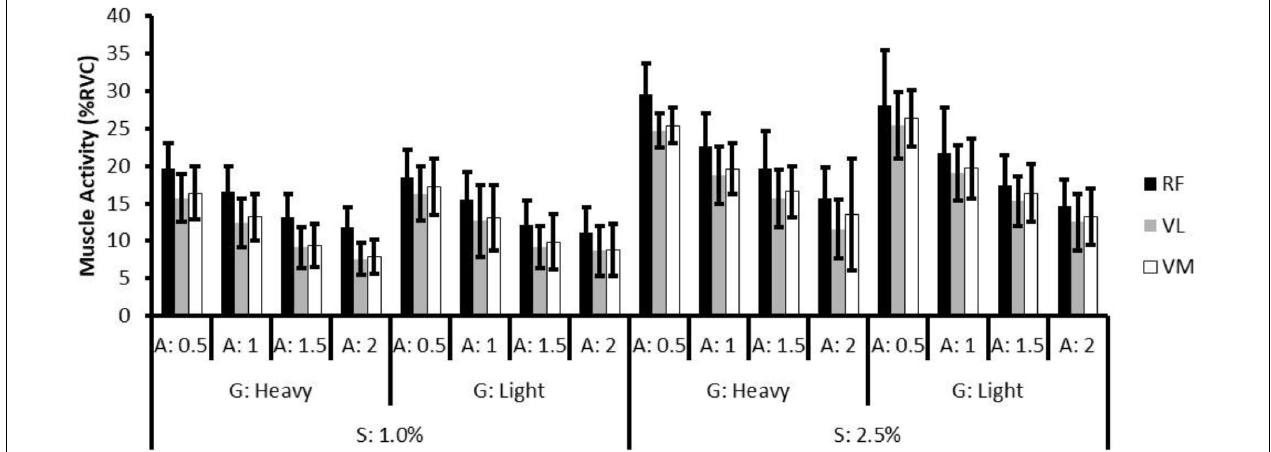
FIGURE 3 | The mean and standard deviation muscle activity of rectus femoris (RF), vastus lateralis (VL), and vastus medialis (VM) in all conditions. S, slope; G, gear ratio; A, assistive level.